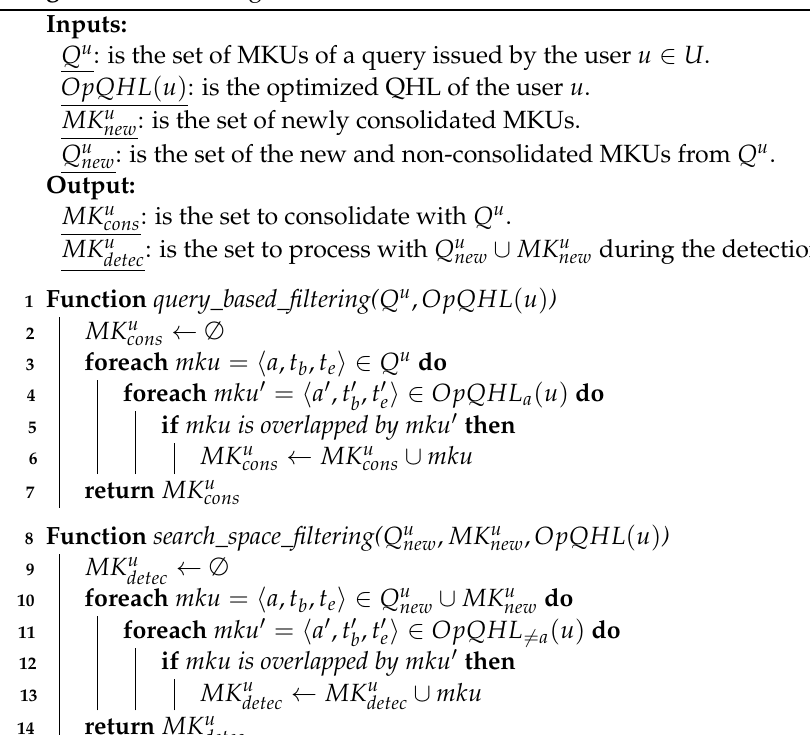
Algorithm 3: Filtering modules for the consolidation and the